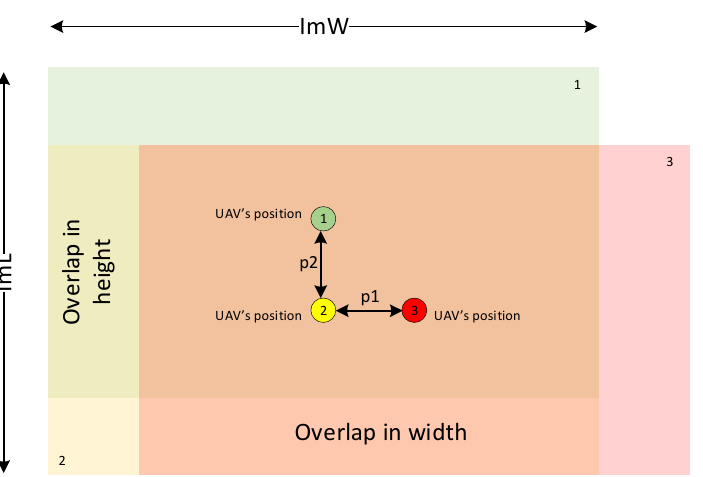
Figure 3. Demonstration of frame overlap in width and height. Each color corresponds to a camera frame: green is the first frame, green circle with number 1 is the center of this frame; yellow color is the second frame, yellow circle with number 2 is the center of this frame; red is the third frame centered on a red circle with the number 3.